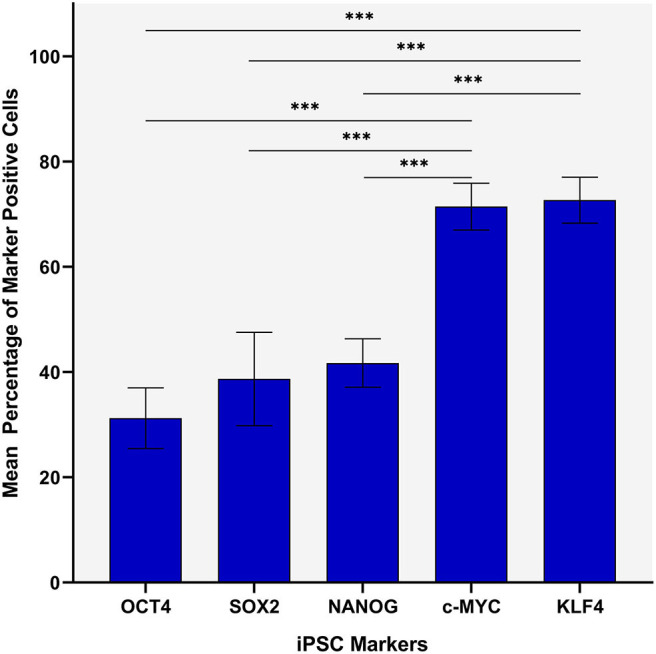
Statistical analyses of cell counting results for immunohistochemical-stained slides of metastatic head and neck cutaneous squamous cell carcinoma demonstrating a statistically significant difference between the mean percentage of cells stained positively in both the TN and the PTS for each induced pluripotent stem cell (iPSC) marker (p < 0.0005). Error bars: 95% confidence interval. ***p < 0.05.